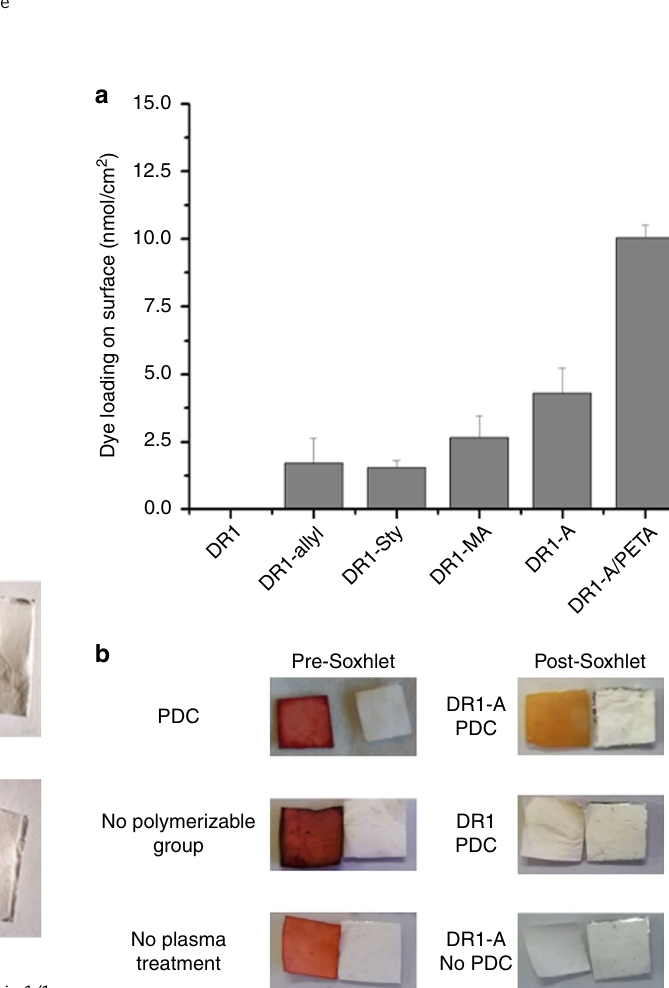
Fig. 4 In fl uence and importance of the radical sensitive moiety. a